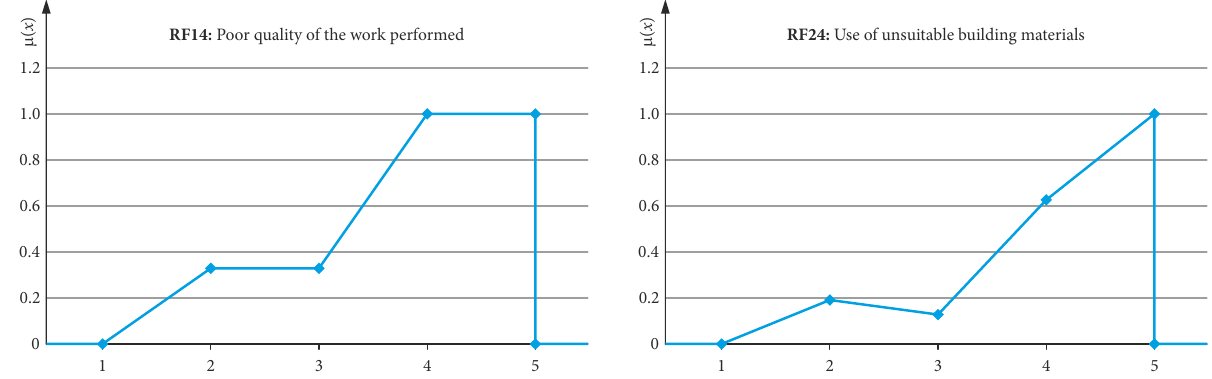
Figure 11. Graphical interpretation of fuzzy numbers for risk factors RF 14 – left and RF 24 – right (own study)